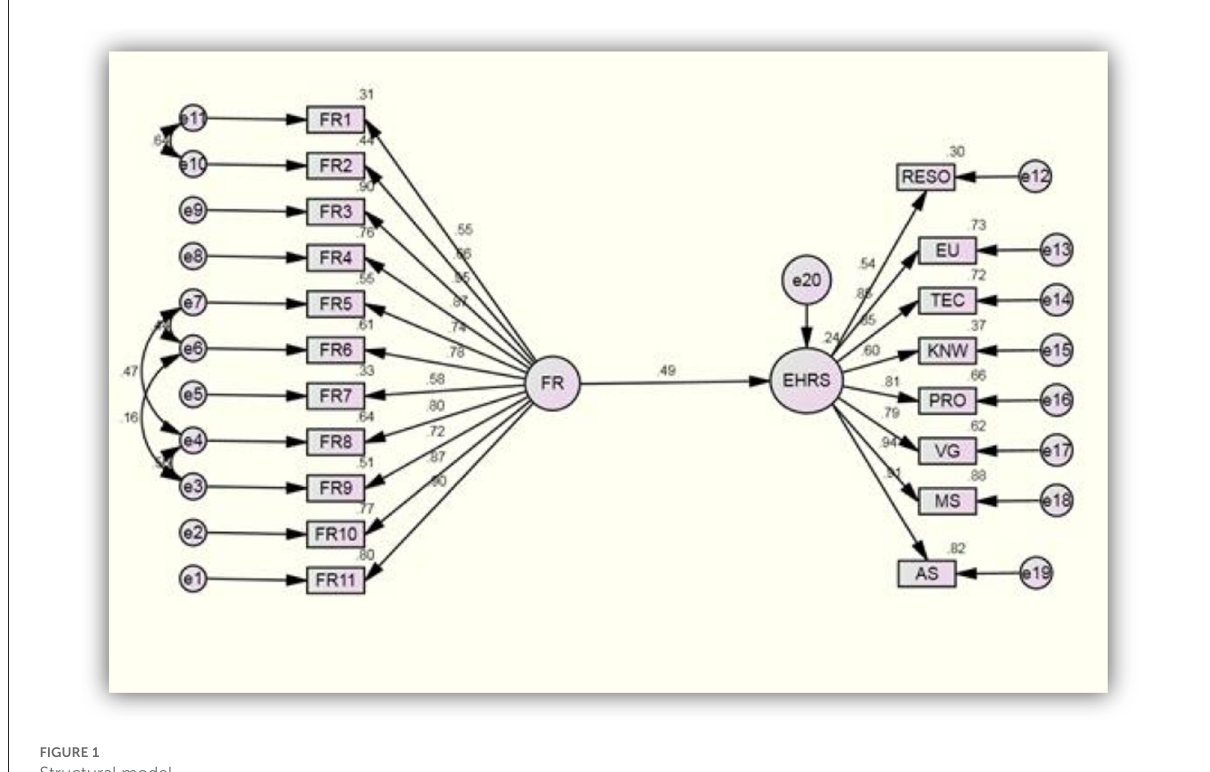
FIGURE1 Structural model.